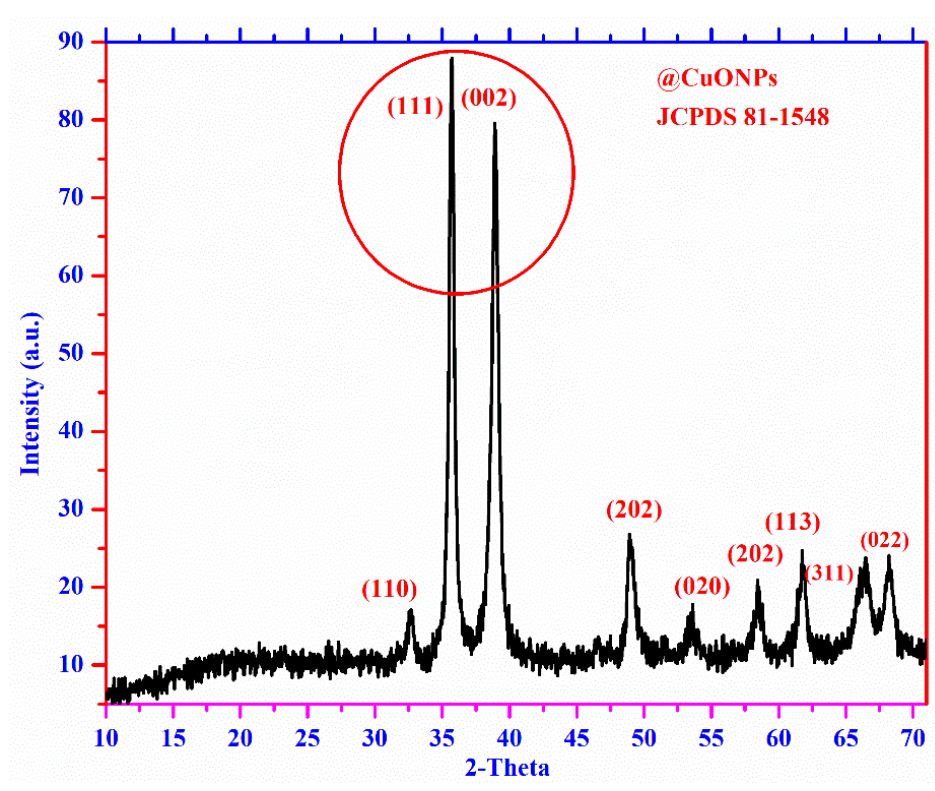
Figure 3. The XRD spectrum of CuONPs.